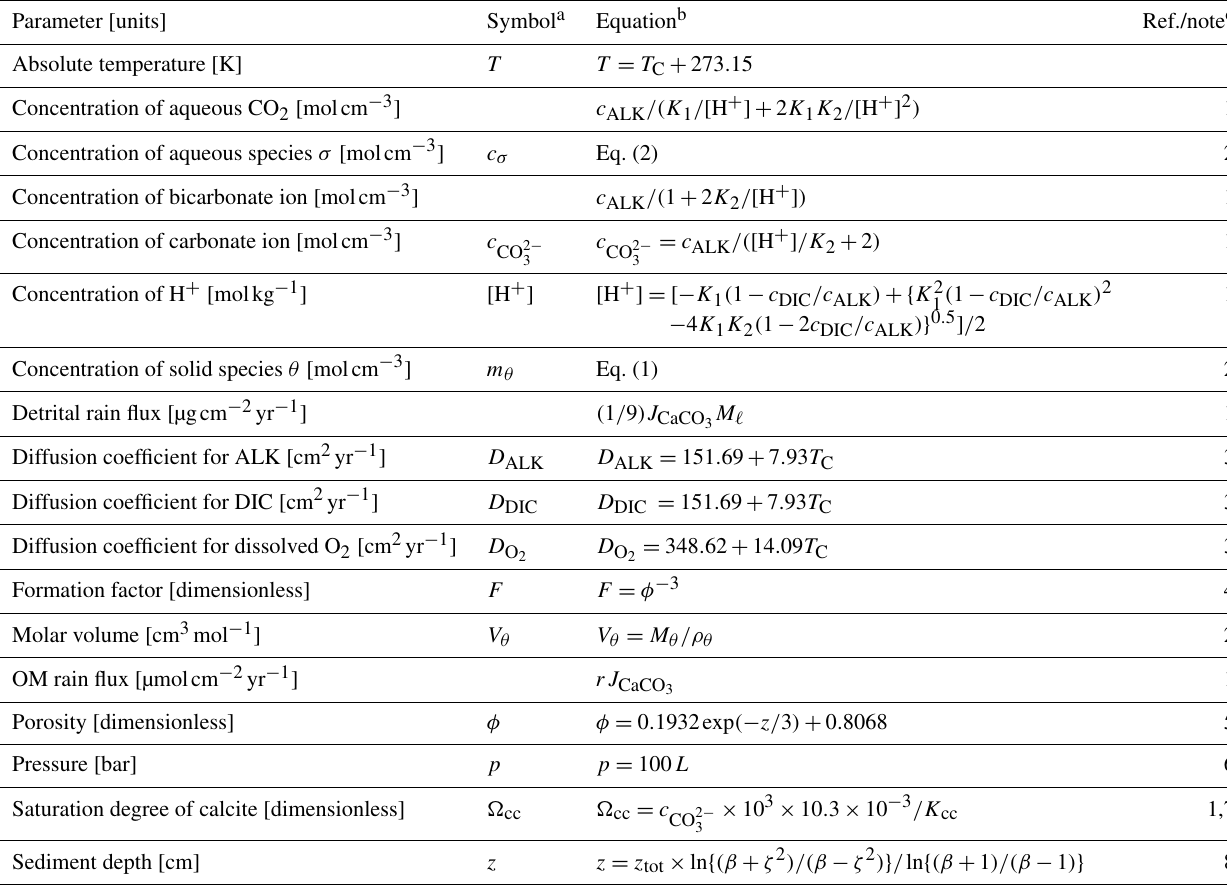
Table 2. Dependent parameters and their